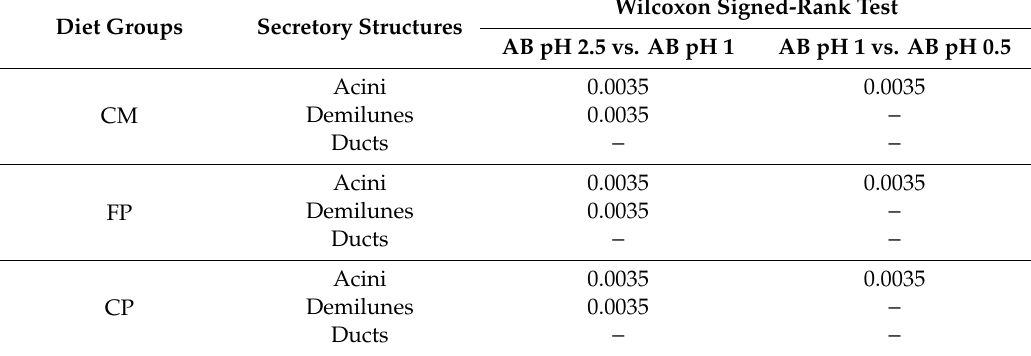
Table 4. Statistical significance of di ff erences ( p ≤ 0.01) among di ff erent pH AB serial treatments as performed by Wilcoxon signed-rank tests. P- values were adjusted for multiple testing using the Holm